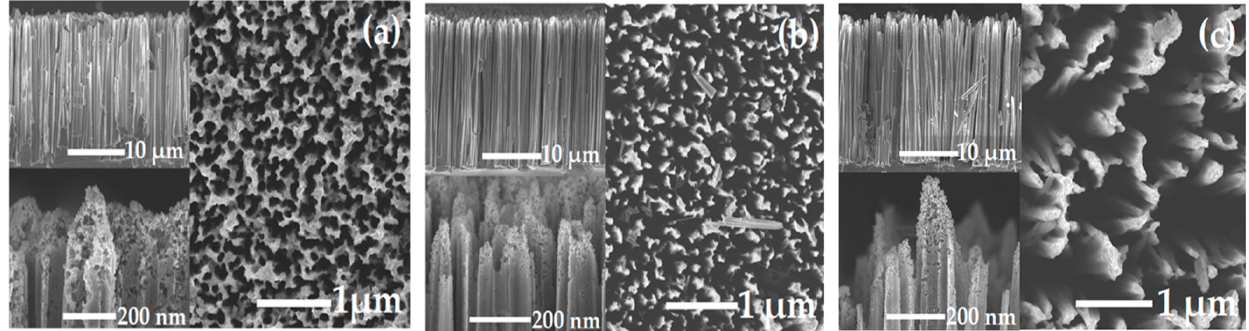
Figure 3. Top-view SEM images of SiNWs:Au-NPs samples prepared at the following time t dep : ( a ) 10 s, ( b ) 20 s, and ( c ) 30 s. Upper and lower insets show lateral views of whole arrays and tips of SiNWs, respectively.